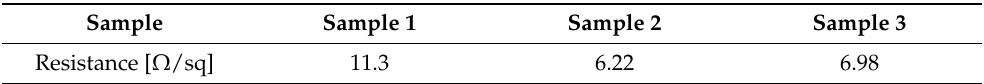
Table 2. Comparison of resistance values between CNT ‐ composite paper with added carbon powder (Sample 3) and other CNT ‐ composite paper (Samples 1 and 2).